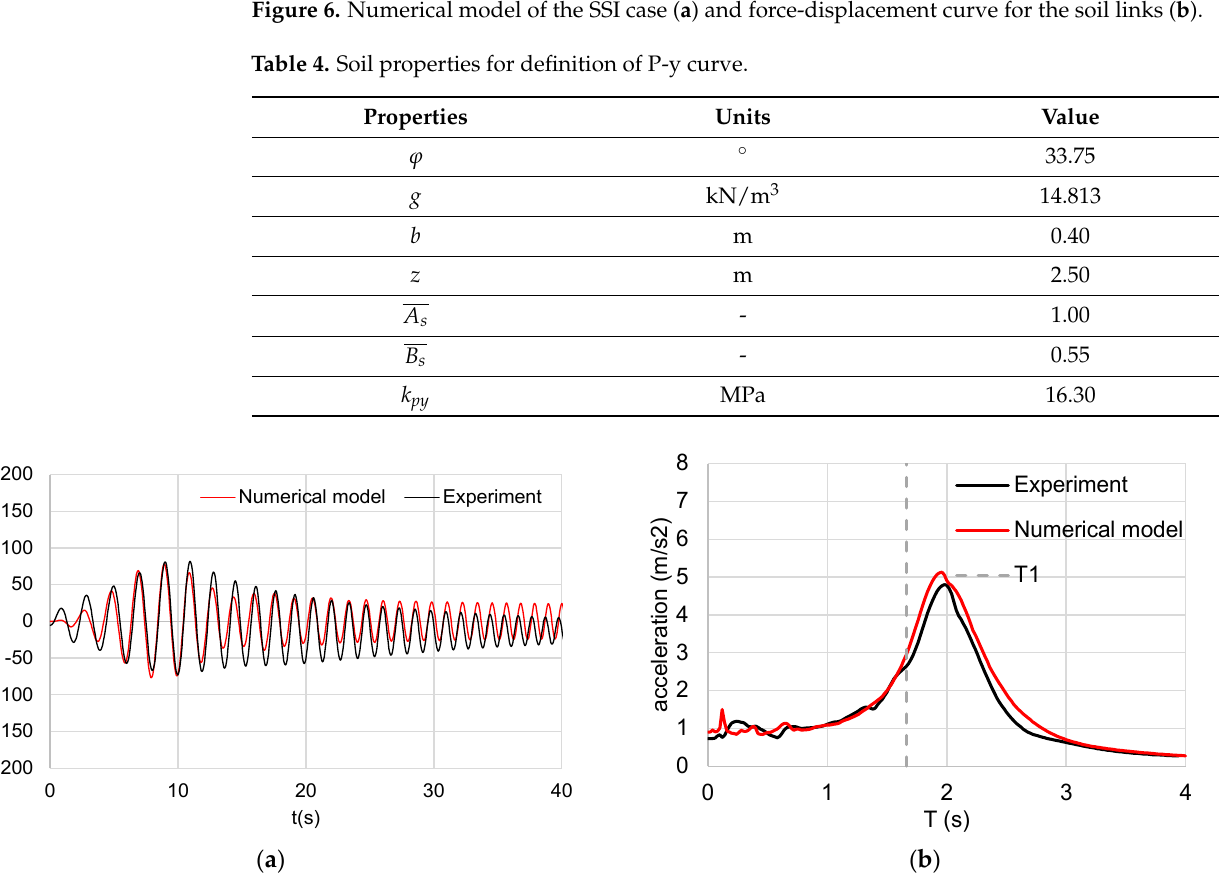
Figure 7. SSI model results for sine sweep excitation: ( a ) displacement of the top beam and ( b ) floor